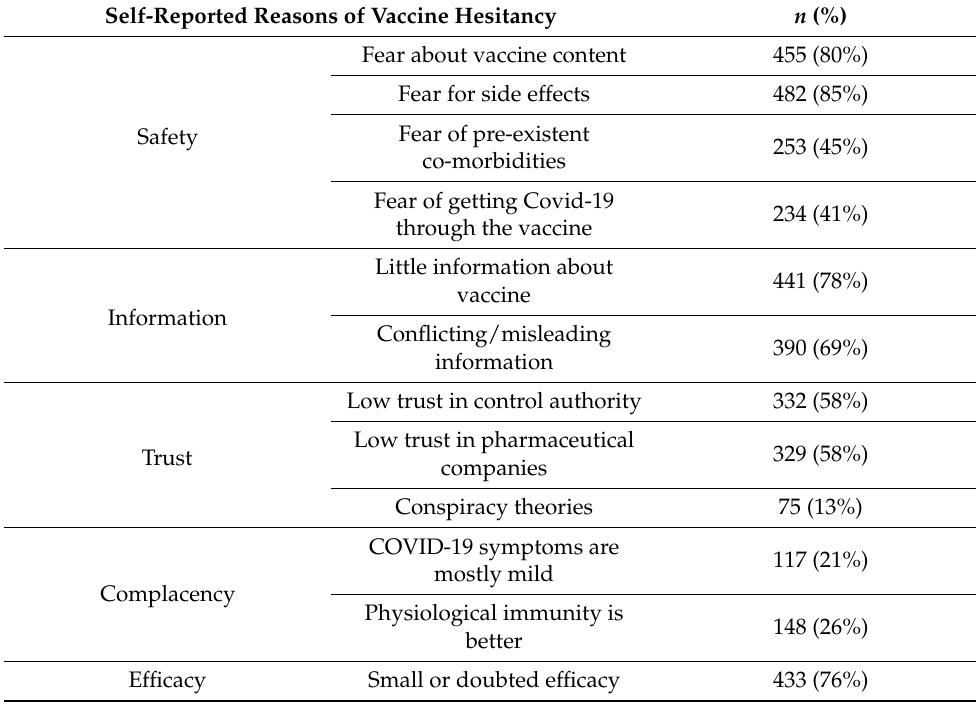
Table 2. Reasons of personal COVID-19 vaccine hesitancy among the 568 hesitant